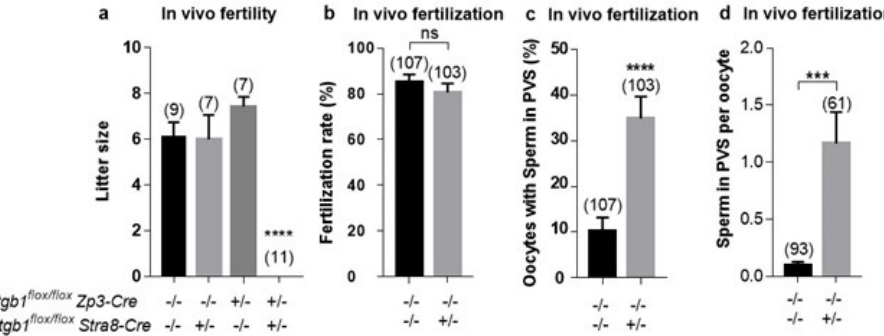
Figure 3. In vivo analysis of the fertilizing ability of Stra8-Cre +/ − Itgb1 flox/flox males (M) and Zp3-Cre +/ − Itgb1 flox/flox females (F). ( a ) Histogram representing the mean litter size of control ( Zp3-Cre − / − Itgb1 flox/flox ) or conditional KO ( Zp3-Cre +/ − Itgb1 flox/flox ) females when mated with control ( Stra8-Cre − / − Itgb1 flox/flox ) or conditional KO ( Stra8-Cre +/ − Itgb1 flox/flox ) males (numbers in parentheses represent the number of litters in each group). No statistical difference was revealed between the first three groups, whereas the coKO x csKO group gave no pups ( p < 0.0001). ( b ) No significant difference in fertilization rate (mean ± s.e.m.) was obtained following in vivo fertilization (IVF) assay when control females were mated with control or csKO males. ( c ) Percentage of control oocytes ( Zp3-Cre − / − Itgb1 flox/flox ) that accumulate sperm in their PVS after in vivo mating with control ( Stra8-Cre − / − Itgb1 flox/flox ) or conditional KO ( Stra8-Cre + / − Itgb1 flox/flox ) males ( p < 0.0001). ( d ) Each oocyte inseminated by control sperm contained an average of 0.09 sperm; those inseminated with csKO sperm contained an average of 1.16 ( p < 0.0003). In ( b – d ), the numbers in parentheses represent the number of used oocytes in each group. *** p < 0.001. **** p <